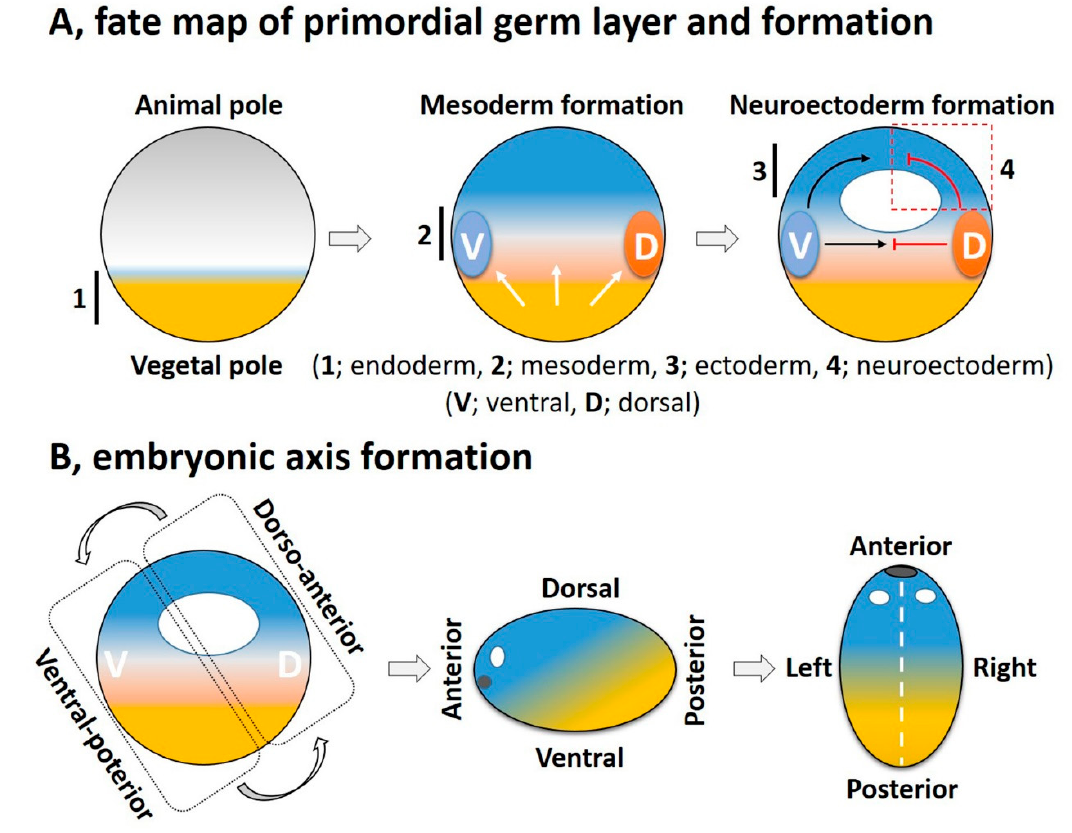
Figure 2. The fate map and key steps in overall embryonic germ layer and axes formation. ( A ) Vegetal pole (endoderm) contains higher amounts of maternal factors that generate the mesoderm inducing signals (white arrows). These mesoderm inducing signals establish the ventral (V) and dorsal (D) signaling centers. Finally, dorsal signals (BMP antagonists) antagonize the ventral and allow the neuroectoderm formation (red dotted box), as ventral signaling commences the ectoderm (epidermis) specification. ( B ) Sequential steps in embryonic axes formation: Dorsal and ventral halves extend to give the anterior and posterior axes, respectively. The left–right (LR) axis establishes the neurula stage embryos by a symmetry breaking signal. The LR axis is generally described by positioning of the visceral organs along the midline (white dotted line).